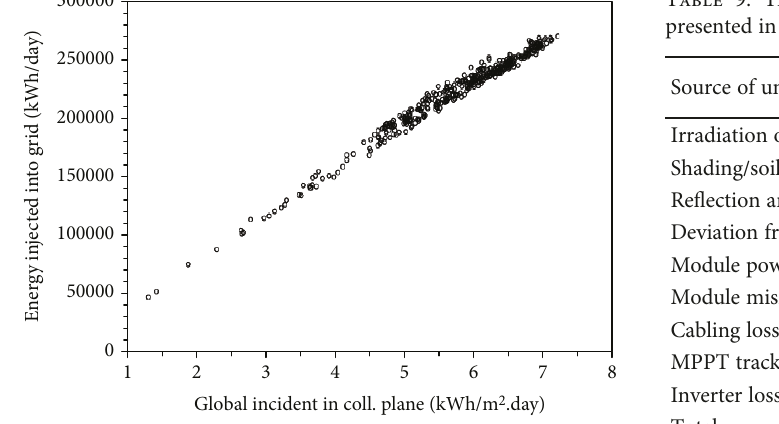
Figure 9: Daily input/output energy diagram.